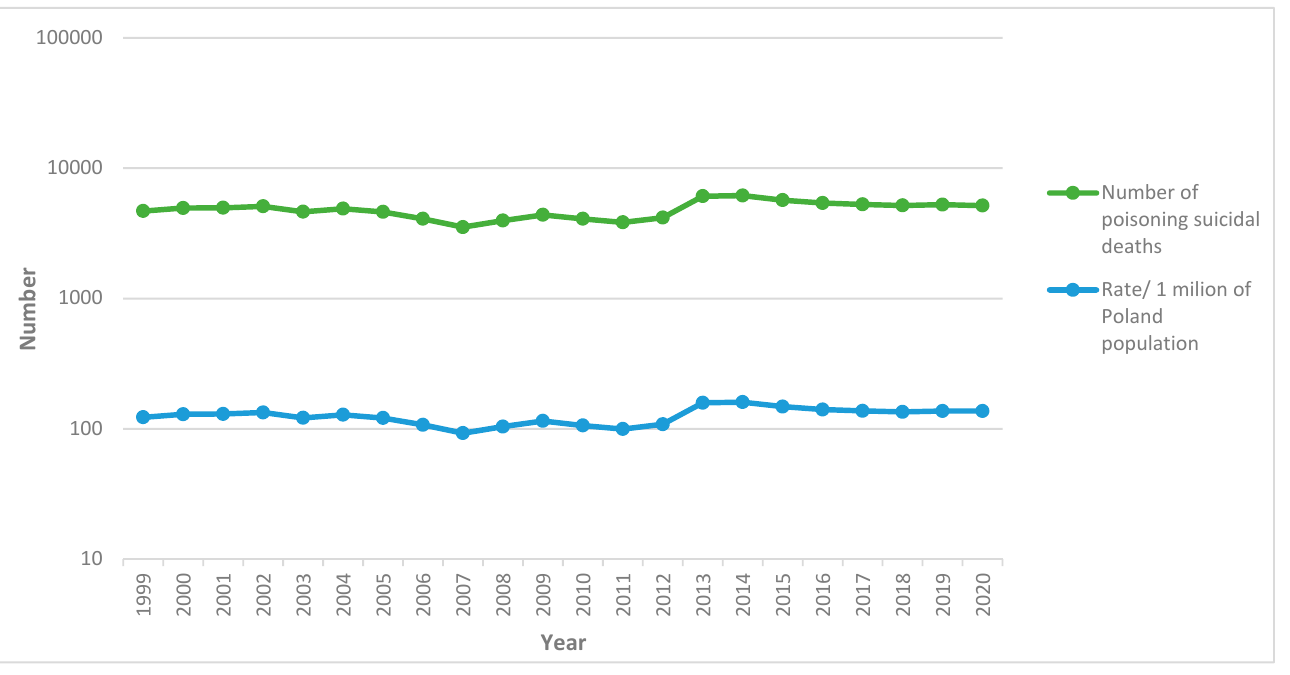
Figure 2. The numbers of suicide deaths and population rates caused by intoxication per 1 million of the population, Poland, 1999–2020 (source: own study). Note: The population of Poland was quite constant over the period of the study. Poland has a population of nearly 38 million people [18].